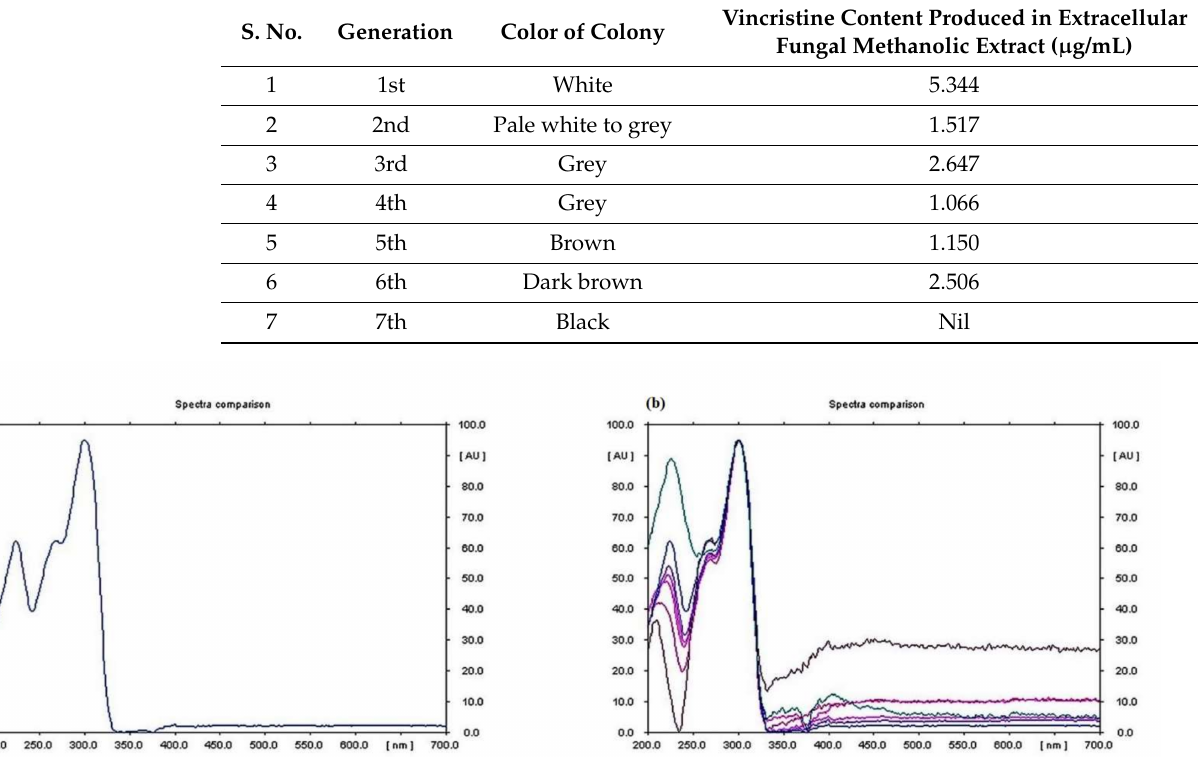
Table 1. Comparative data of generation study of desired fungal strain Nigrospora zimmermanii .